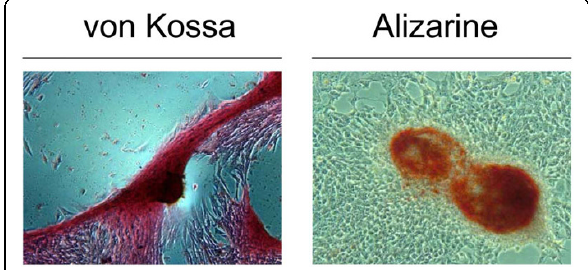
Figure 6 Stably transfected EADSCs maintains differentiation properties . Representative images (20×) of von Kossa and alizarin stained stable green G418 selected EADSCs obtained with pCMV- EGFP/ neo